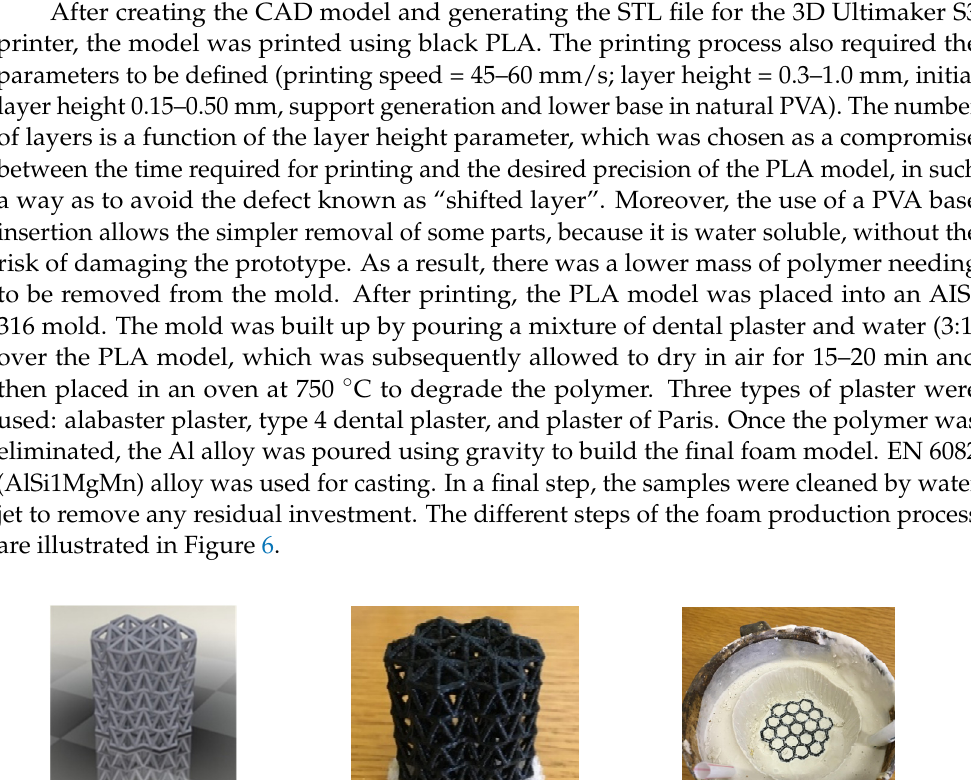
Figure 5. Printed PLA foams: ( a ) hexagonal with rectangular cell; ( b ) truncated octahedron; ( c ) icosahedron.